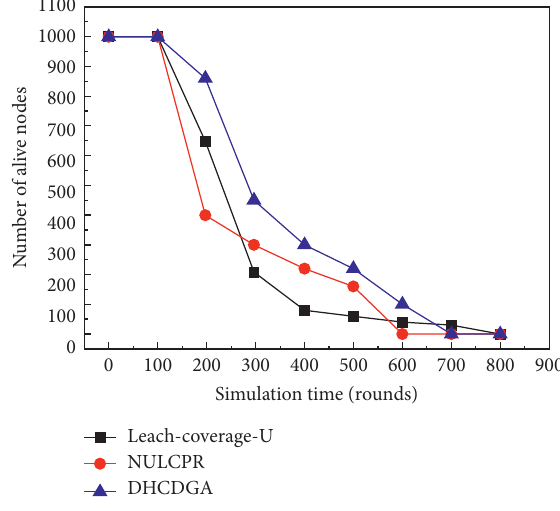
Figure 5: Number of alive nodes.